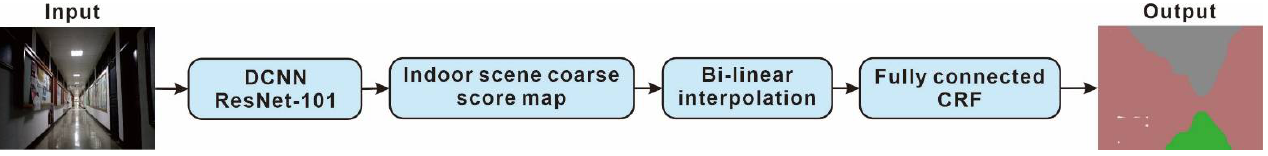
Figure 6. Indoor segmentation model.